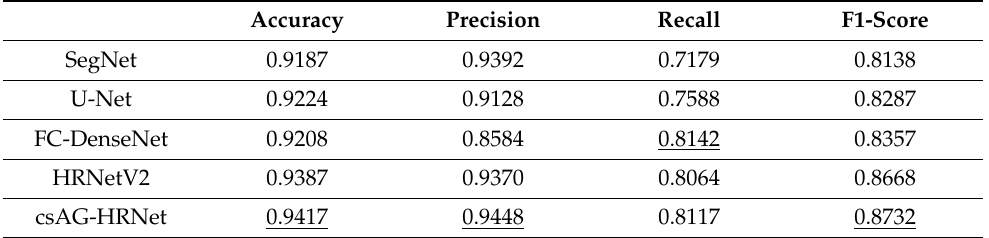
Table 4. Quantitative building extraction results for site 2 according to each deep learning model.